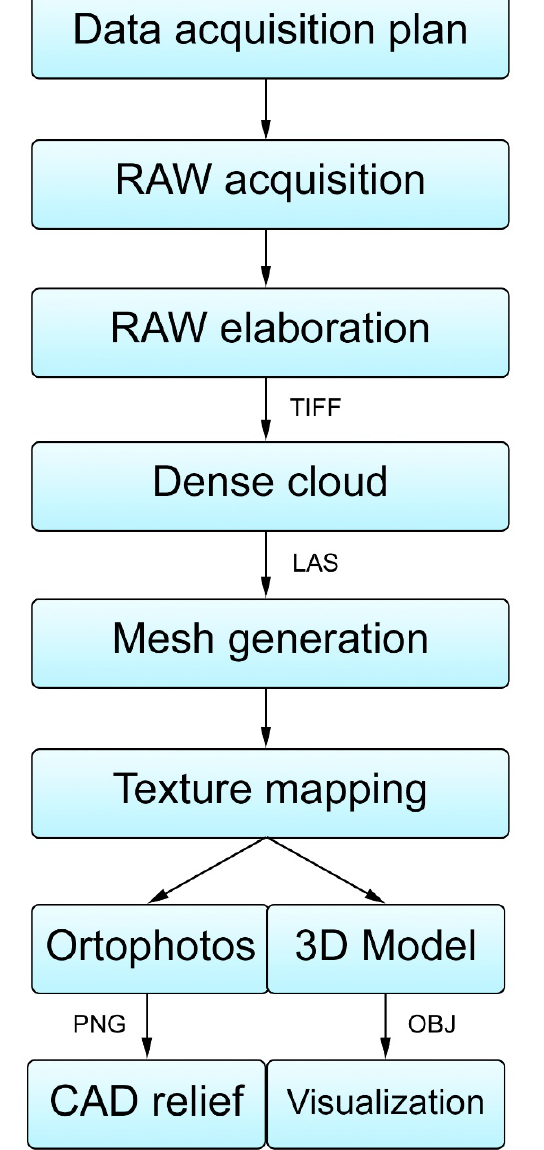
Fig. 1 Typical workflow for image-based 3D modelling. Inside the museum the objects were stored on mobile brackets of different size suitable for the shooting of the lower part of the vessels. To date all objects, a standard workflow and